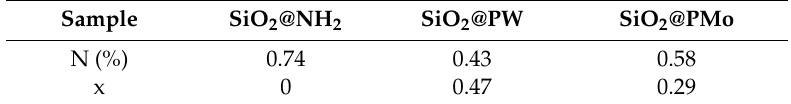
Table 1. POM / NH 2 molar ratio (x) obtained through elemental analysis (EA) data.